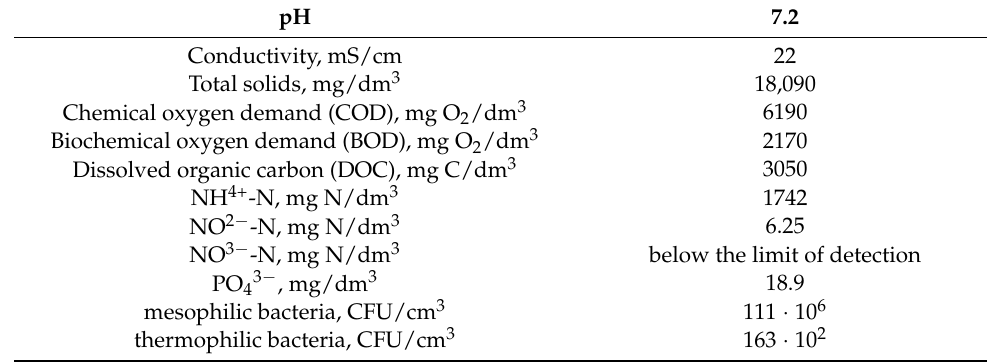
Table 2. Properties of the liquid digestate fraction from the municipal waste biogas